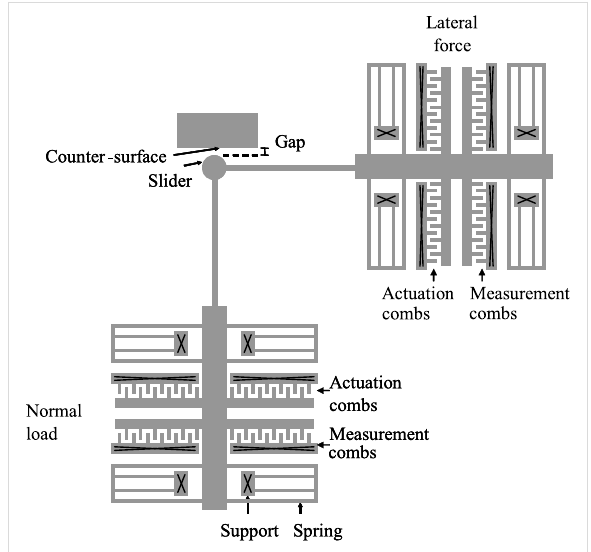
Figure 1: Schematic top view of the MEMS tribometer for studying microscale friction [19]. Several slider types have been investigated, such as the disc-shaped one in this figure. The experiments reported in the current paper have been performed with a square slider, resulting in two parallel sidewall surfaces sliding over one another. The slider surface is 20 μ m by 2.0 μ m, the counter-surface has the same 2.0 μ m height but is much longer. Only the measurement shown in Figure 2 was performed with a small square slider of 4.0 μ m by 2.0 μ m. [Reprinted with permission from van Spengen, W. M.; Frenken, J. W. M. Tribol. Lett. 2007, 28,